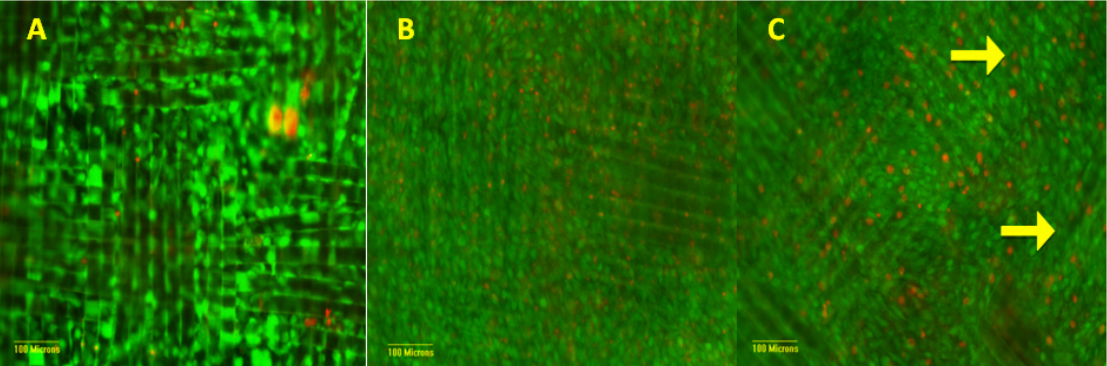
Figure 7. Live/Dead images of section 2 of each scaffold magnified at 10×. Green represents those cells that are alive/viable and red represents those cells that are dead/non-viable. ( A ) Control; ( B ) Unstretched; ( C ) Stretched. Arrows signify cells aligning along scaffold